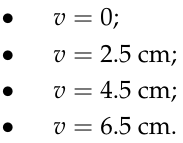
Table 2. First test: Specimen parameters.